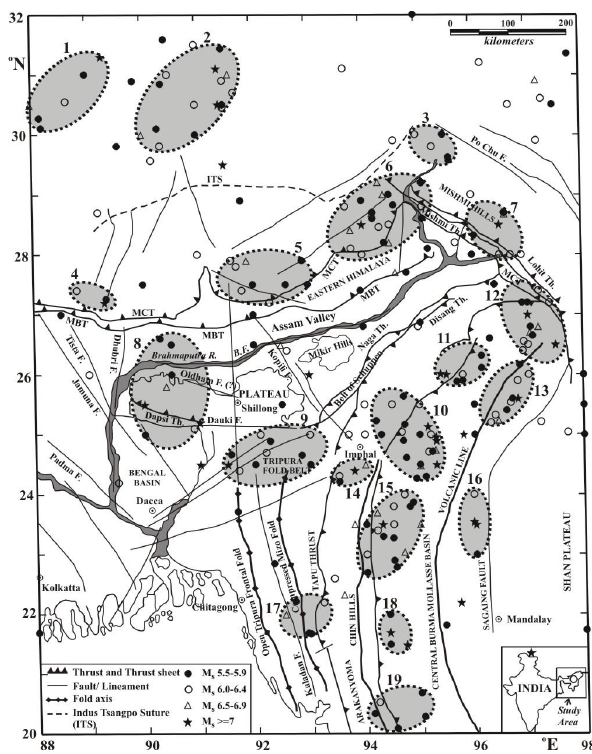
Fig. 2. Earthquake plots with M s ≥ 5 . 5 for the period 1906–2008 in northeast India and its adjoining regions with nineteen seismogenic sources over major tectonic features of the area. The seismogenic sources are separated by shaded elliptical